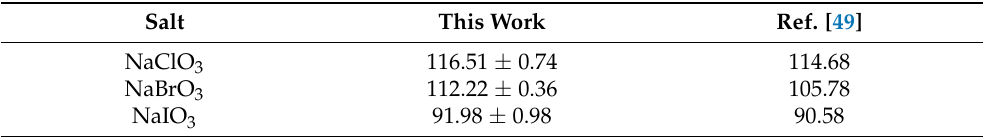
Table 3. Limiting molar conductivity ( Λ ∞ , in S · cm 2 · mol − 1 ) values at 25 ◦ C of sodium chlorate, bromate, and iodate solutions obtained from the fitting of Equation (A10) and from Ref.